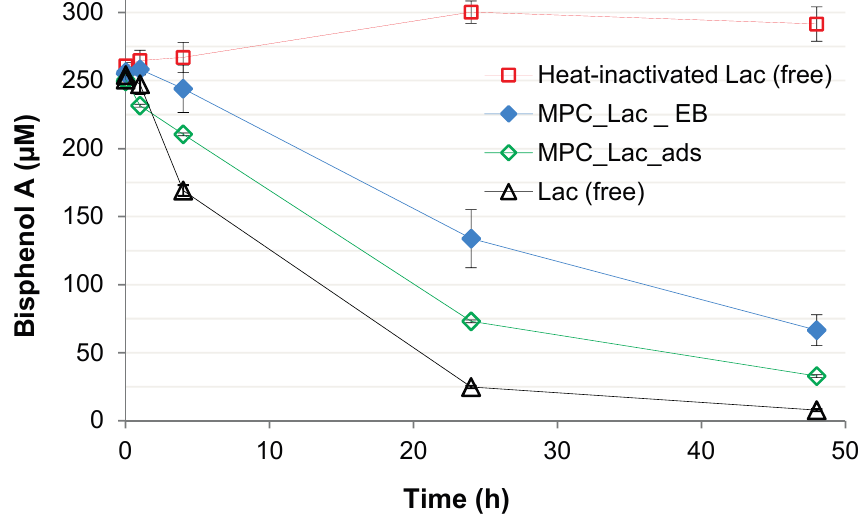
Figure 7. Time courses of BPA concentrations in degradation experiments with cryogels containing E-Beam-immobilized laccase (MPC_Lac_EB) and cryogels containing unspecifically adsorbed laccase (MPC_Lac_ads). BPA concentrations in control experiments employing freely suspended, heat-inactivated laccase are also shown (please refer to the Experimental Section for details). Data always represent means ± standard deviations for triplicate